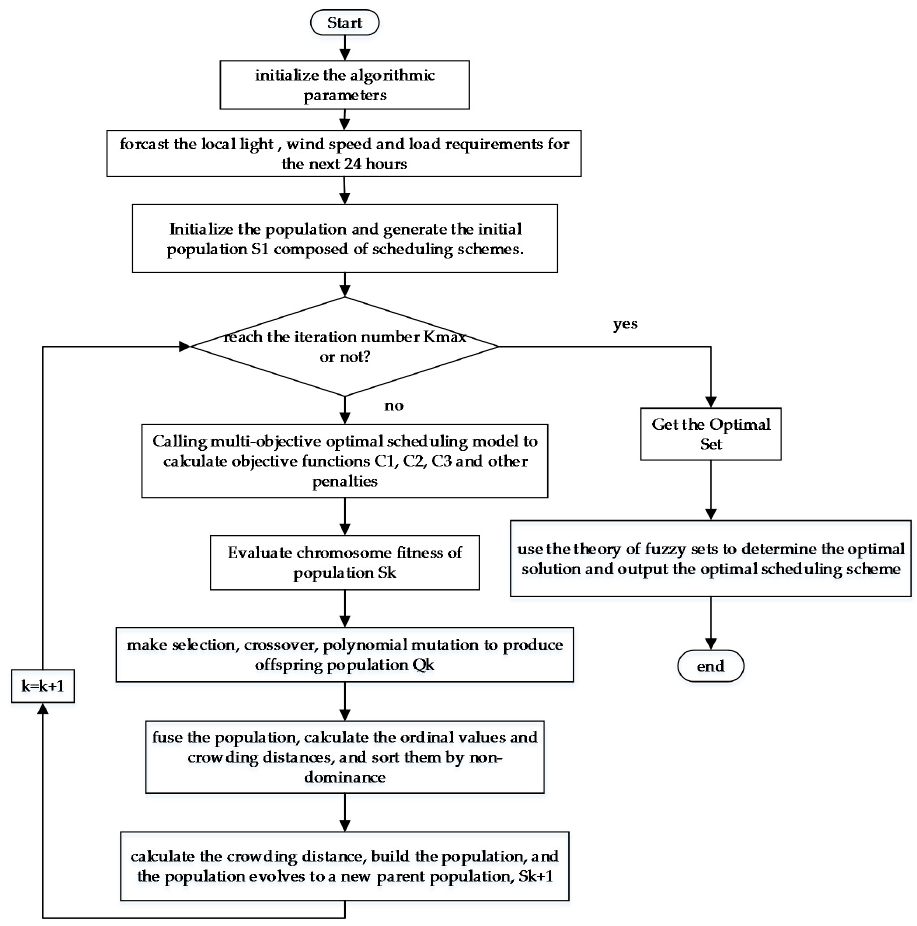
Figure 2. Flow chart for solving microeconomic optimization model based on a variant of NSGA-II algorithm.